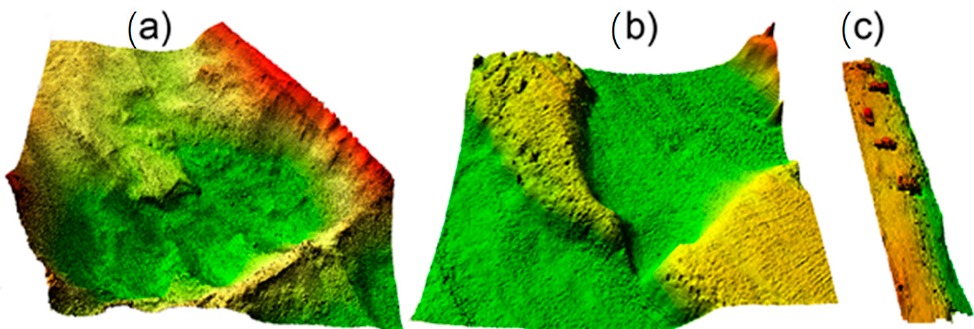
Fig ure 1. Test surfaces: ( a ) ‘gate’ ( b ) ‘swinging’ ( c ) ‘wrecks’. Figure 1. Test surfaces: ( a ) ‘gate’ ( b ) ‘swinging’ ( c ) ‘wrecks’.